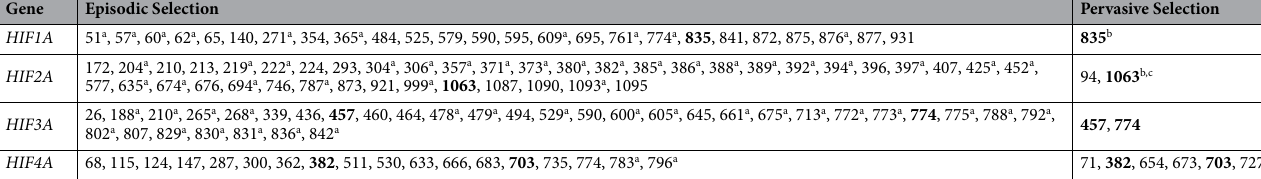
Table 3. Codons putatively under positive selection in HIFA genes in Actinopterygii. Episodic positive selection was detected by MEME and pervasive positive selection was detected by FEL. Codons detected by both tests are shown in bold type. Codon number corresponds to the position in the multiple sequence alignment of all HIFA genes used in each analysis. See Supplemental Table S3 for amino acid identities in each species for each HIFA paralog. a Episodic positive selection supported by BUSTED evidence ratio > 2. b Pervasive positive selection supported by SLAC posterior probability > 0.95. c Pervasive positive selection supported by FUBAR posterior probability > 0.95.